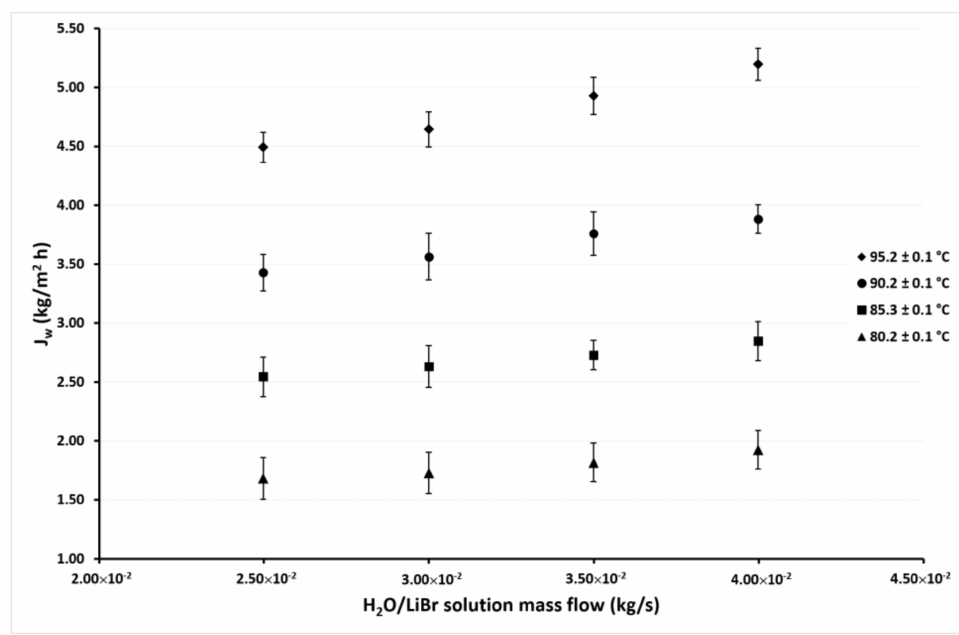
Figure 6. Desorption rate as a function of the ˙m LiBr with T cw,in = 40.1 ± 0.1 ◦ C.